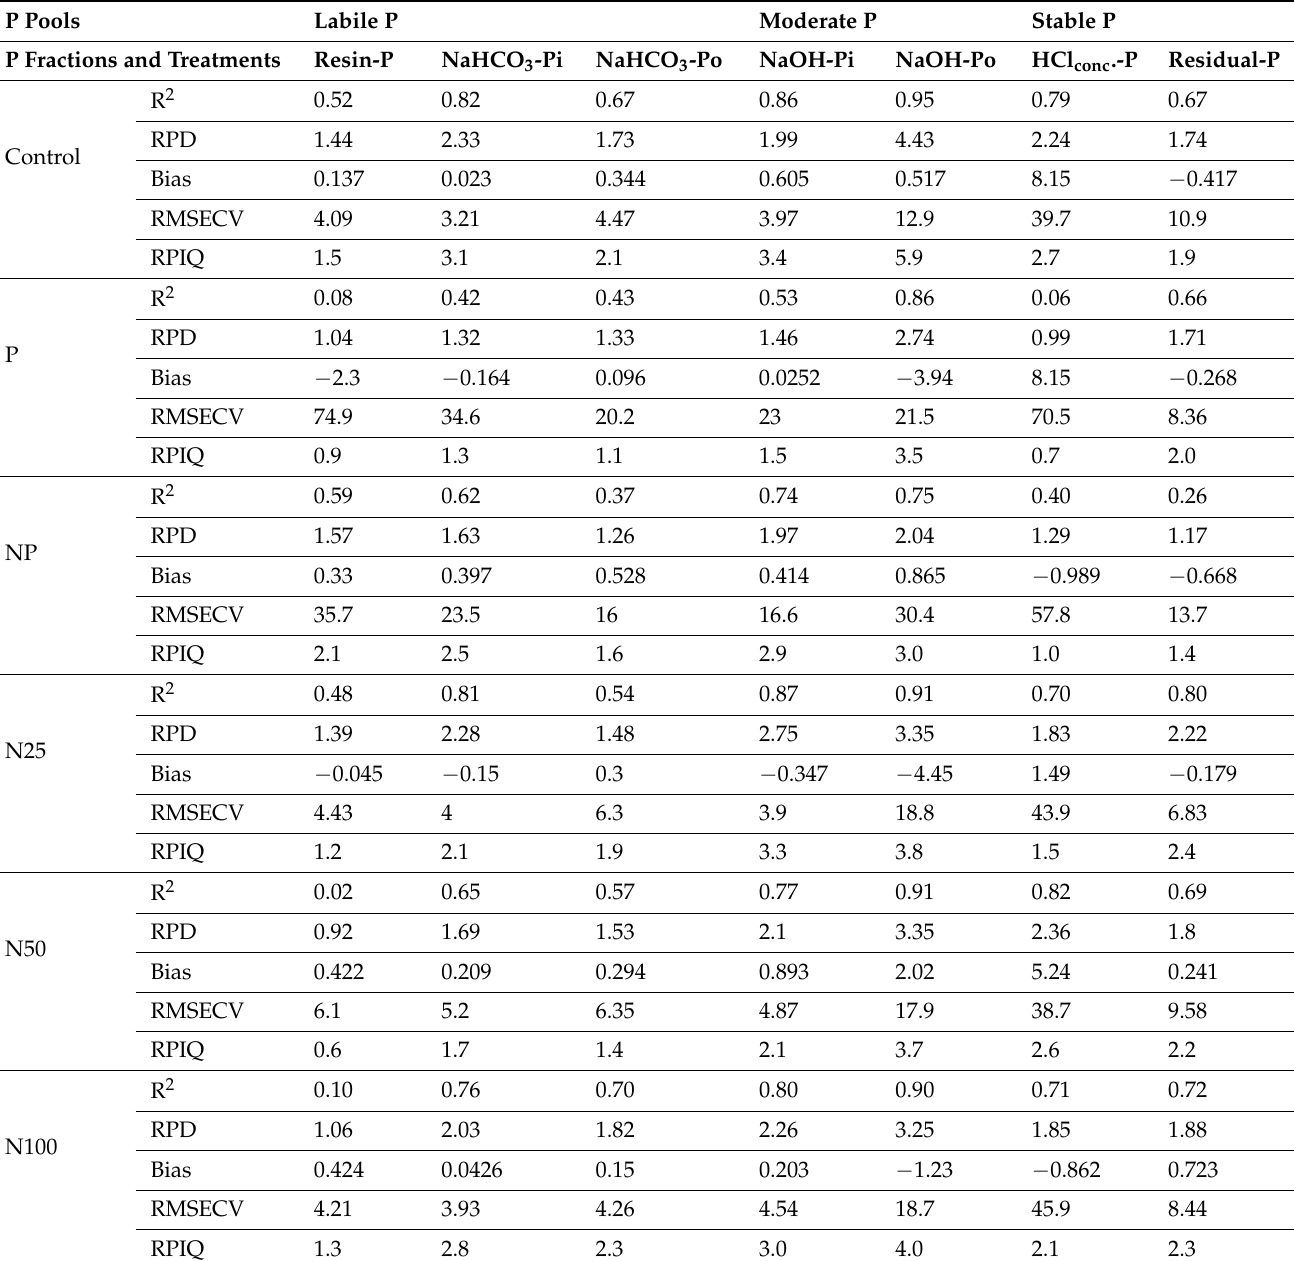
Table 4. Quality parameters for NIRS model calibration in the cross-validation process for all Hedley fractions with different